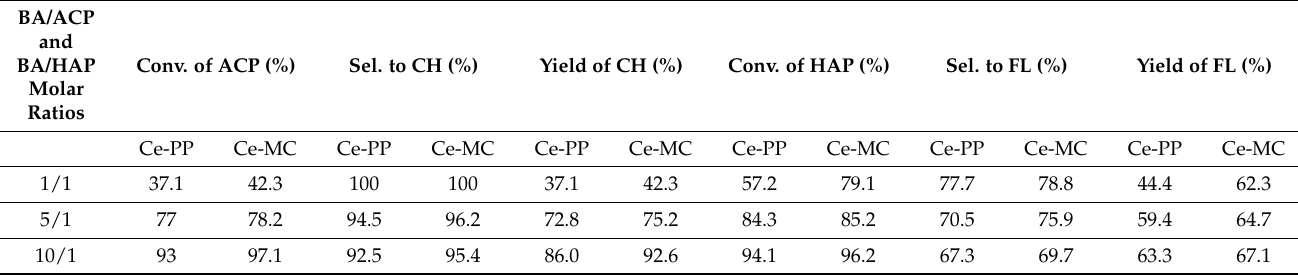
Table 6. Conversion (Conv.), selectivity (Sel.), and yields obtained on Ce-PP and Ce-MC mixed oxides catalysts operating at different molar ratios of BA/ACP or BA/HAP under reflux conditions. BA/ACP and BA/HAP Conv. of ACP Molar Ratios